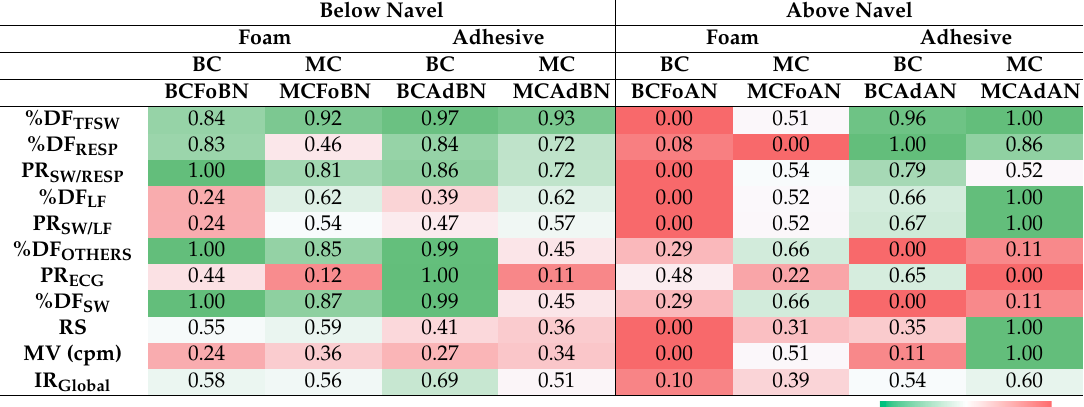
Table 5. IR values for the eight combinations of recordings factors and for the 10 parameters defined. Below Navel